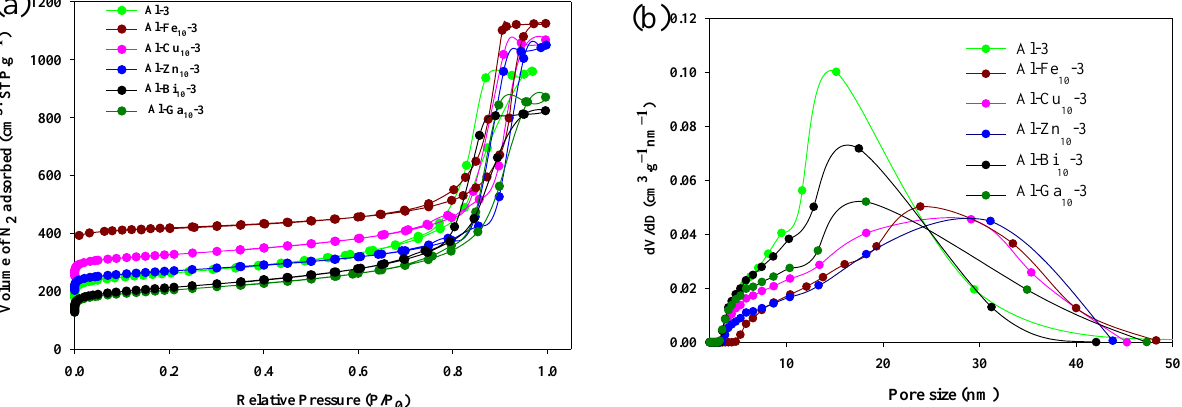
Figure 5. N 2 adsorption/desorption isotherms for various samples ( a ) with the corresponding pore- size distribution curves ( b ) (obtained from the adsorption branches). For clarity, the isotherms for Al 2 O 3 -3 , Al-Fe 10 -3, Al-Cu 10 -3, Al-Zn 10 -3 , Al-Bi 10 -3, Al-Ga 10 -3 in ( a ) are offset along the y -axis by 175, 350, 250, 200, 225, and 125 cm 3 ·g −1 , respectively.